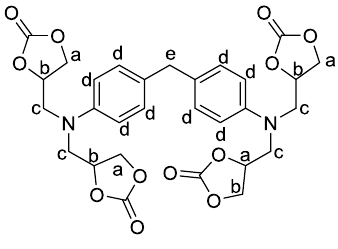
Figure 9. MBDAC structure.